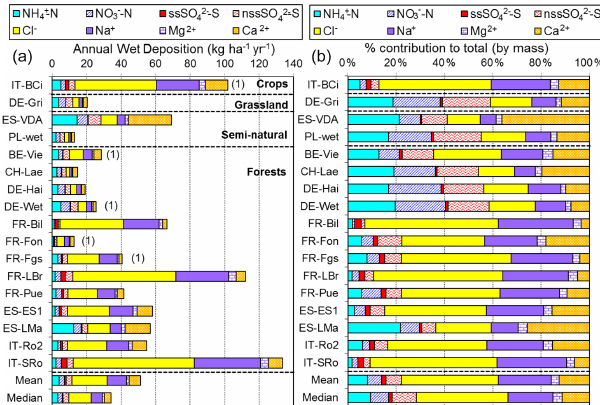
Figure 16. (a) Annual wet deposition of inorganic components (kgha − 1 yr − 1 ) estimated from Rotenkamp bulk precipitation col- lectors in the NEU bulk wet-deposition network. (b) Percentage contribution of inorganic components to total (by mass) measured at 17 sites from 2008 to 2010. The data shown are 2-year-averaged deposition, made between 2008 and 2010, except at five sites with 1 year of measurement only, as indicated in the graph in